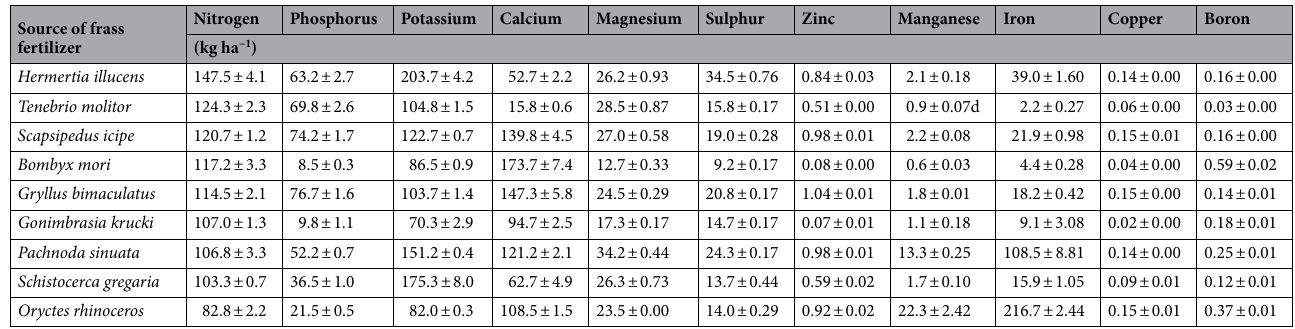
Table 3. Nutrients in frass fertilizers if applied at the rate of 5 t ha −1 for crop production. Mean (± standard error), n =